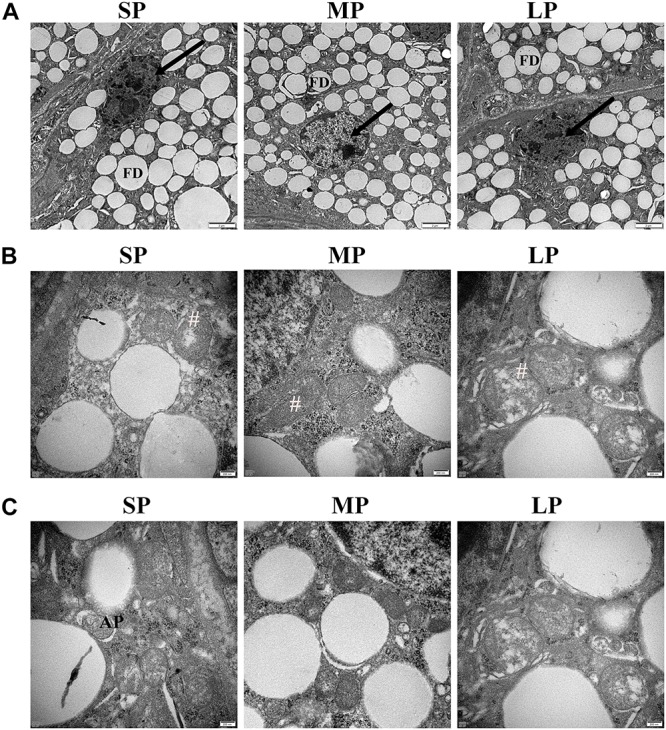
Ultrastructure of HG in hamsters from three photoperiodic groups. (A) Nucleus ultrastructure of HG in hamsters from three photoperiodic groups. In SP and LP groups of hamsters, nuclei of secreting cells were deformed, and chromatin were condensed. Nuclei of mesenchymal cells were irregular, and chromatin was obviously agglutinated. Large number of fat droplets (FD) were observed in secretory cells (see arrow) of HG, and plasma membrane (see asterisk) was smooth and clear. Scale bar = 2 μm. (B) Cristae of mitochondria of HG in hamsters from three photoperiodic groups. In SP and LP groups, mitochondria (#) of secretory cells were swollen and cristae were disordered. Mitochondria in LP group were slightly swollen. In MP group, mitochondria were well formed, and cristae were obvious. Scale bar = 0.2 μm. (C) Autophagolysosomes of HG in hamsters from three photoperiodic groups. Significant autophagolysosomal structures (AP) were observed in SP group. In other groups, autophagolysosomal structures were hardly observed. Scale bar = 0.2 μm. SP, short photoperiod; MP, moderate photoperiod; LP, long photoperiod.